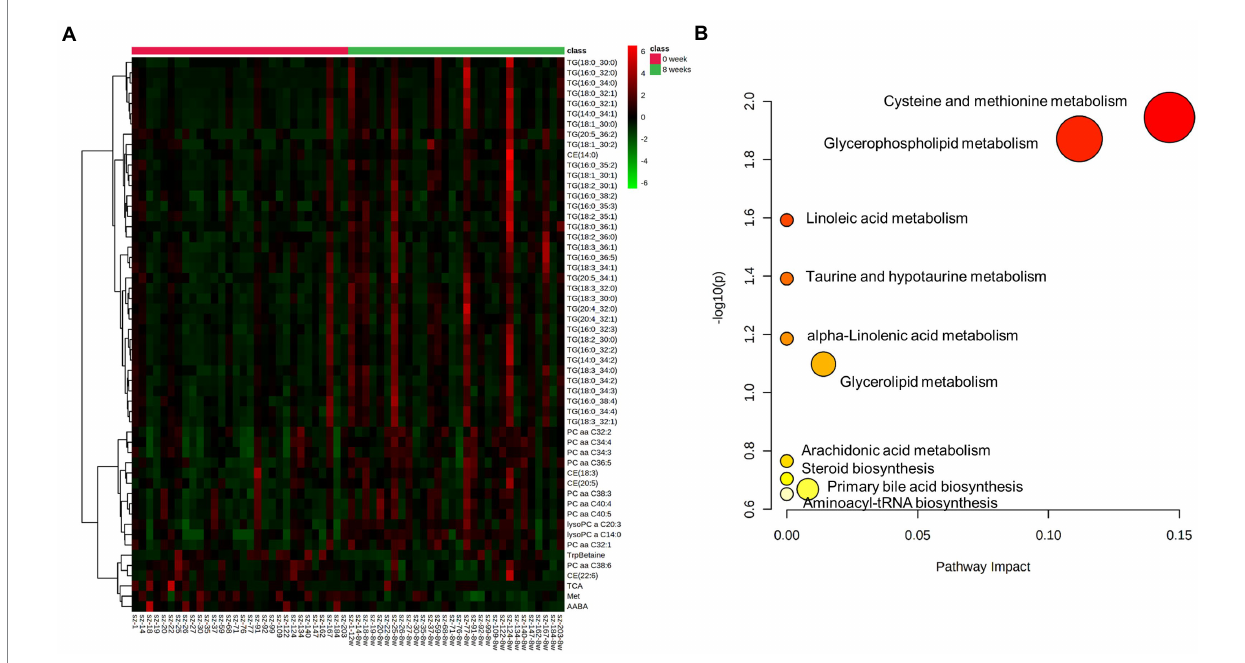
FIGURE 2 Clustering and pathway enrichment analysis of differential metabolites. (A) Heat map of differential compounds by clustering analysis according to their variation trends. (B) Pathway enrichment analysis of differential metabolites. The p value and pathway impact values were calculated from the enrichment analysis and pathway topology analysis,